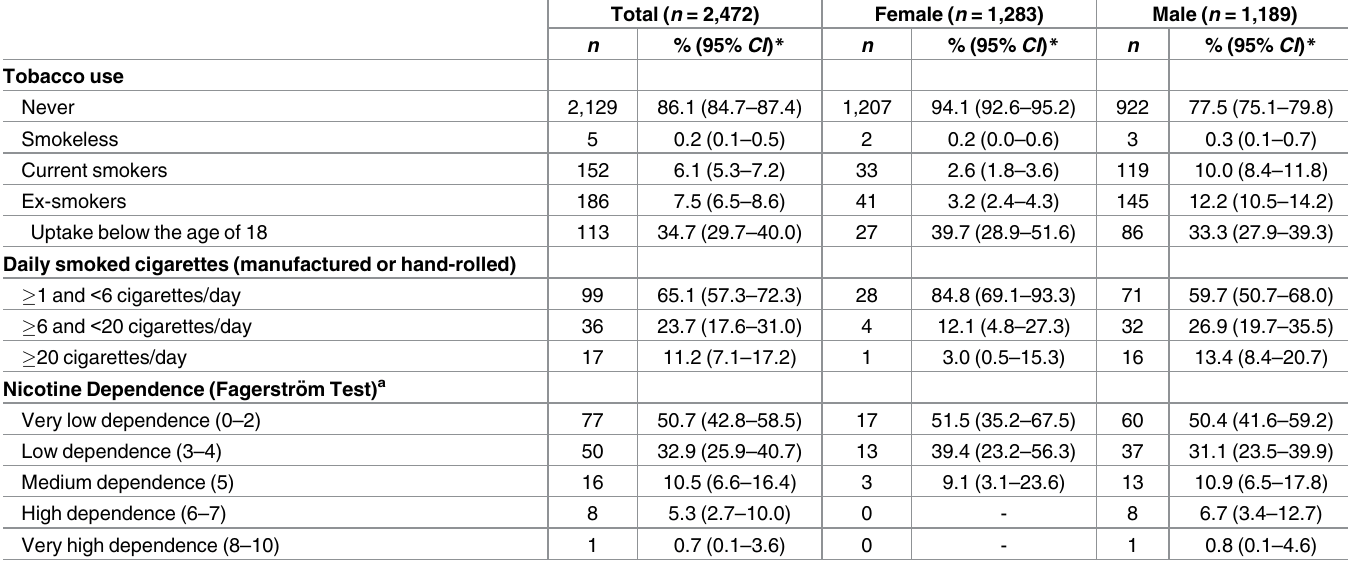
Table 1. Prevalence, characteristics of tobacco use and nicotine dependence in smokers,by